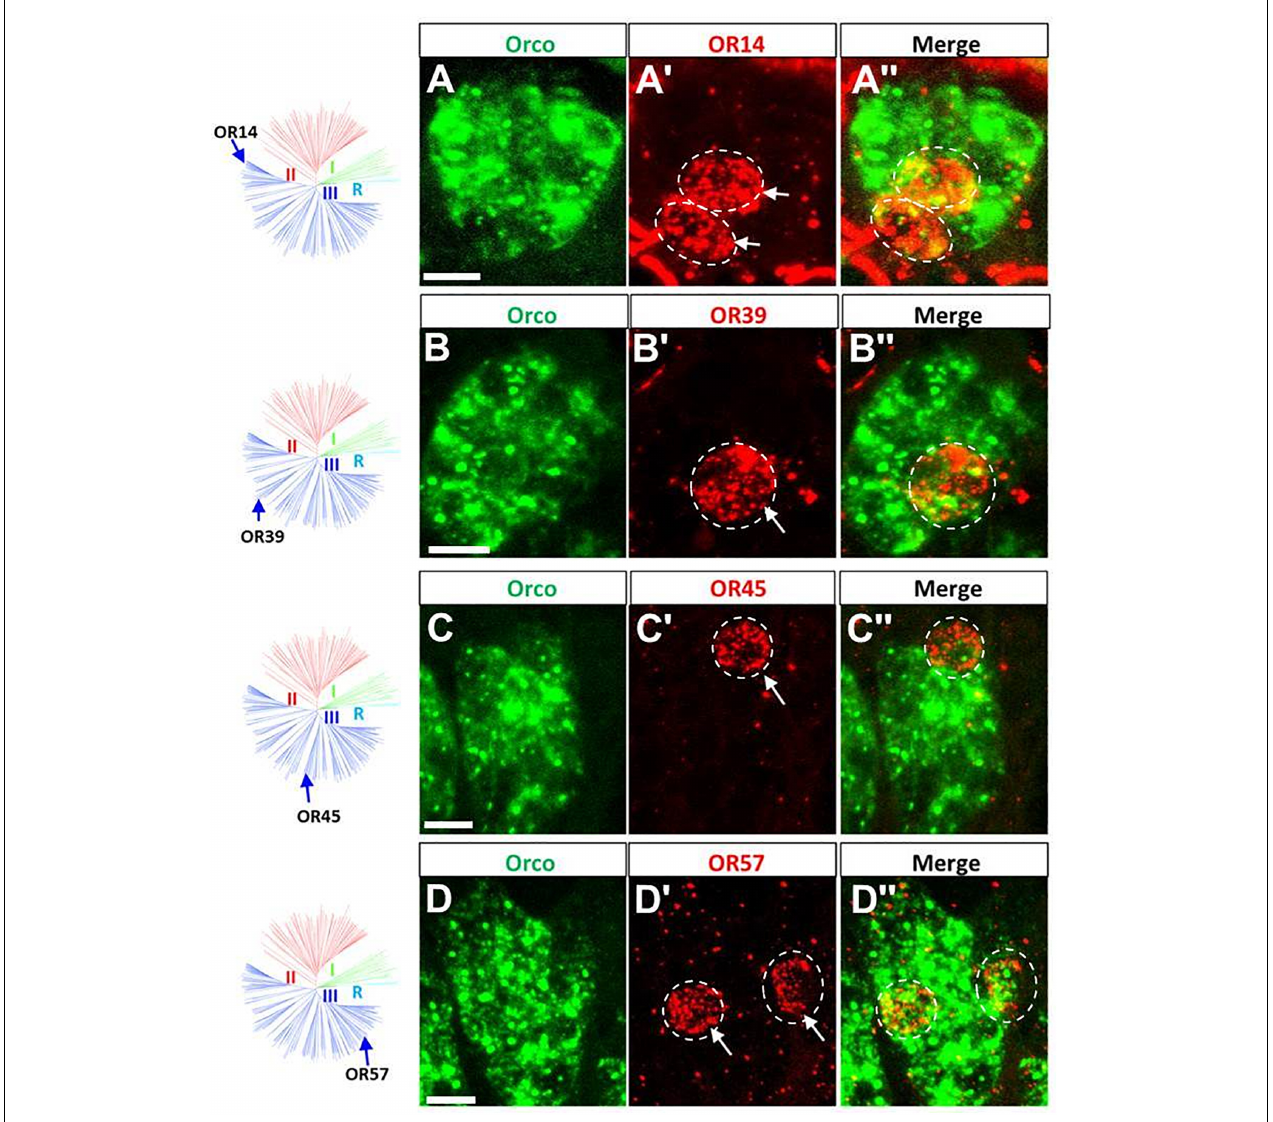
FIGURE 4 | ORs from group III are specifically expressed in sensilla basiconica. The schematic locust OR phylogenetic tree is adapted from Pregitzer et al., 2017 in which R group means Orco rooting group, group I corresponds to the previously classified “b-OR group” and group II and group III are divided based on the branches segregation. The four distinct groups are differentially colored. (A–D”) Cells expressing Orco- and distinct OR types were visualized by means of two-color FISH using specific antisense riboprobes labeled in Bio (green fluorescence) and DIG (red fluorescence), respectively. Four OR types (OR14, OR39, OR45, and OR57) are shown as representatives of group III (blue branches) that are specifically expressed in sensilla basiconica. More examples are shown in the supporting data. Distinct OR-positive cells are indicated by white arrows. The white dash circle highlights the cell that concomitantly expresses the defined OR type and Orco. Scale bars, 10 µ